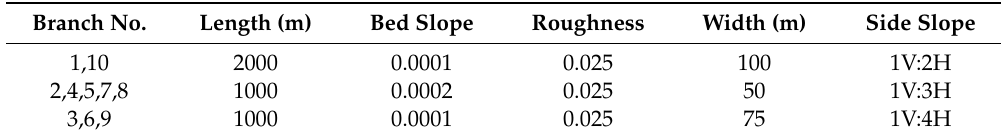
Figure 1. Eulerian–Lagrangian method (ELM) program frame design. Table 1. Loop network 1 channel parameters.